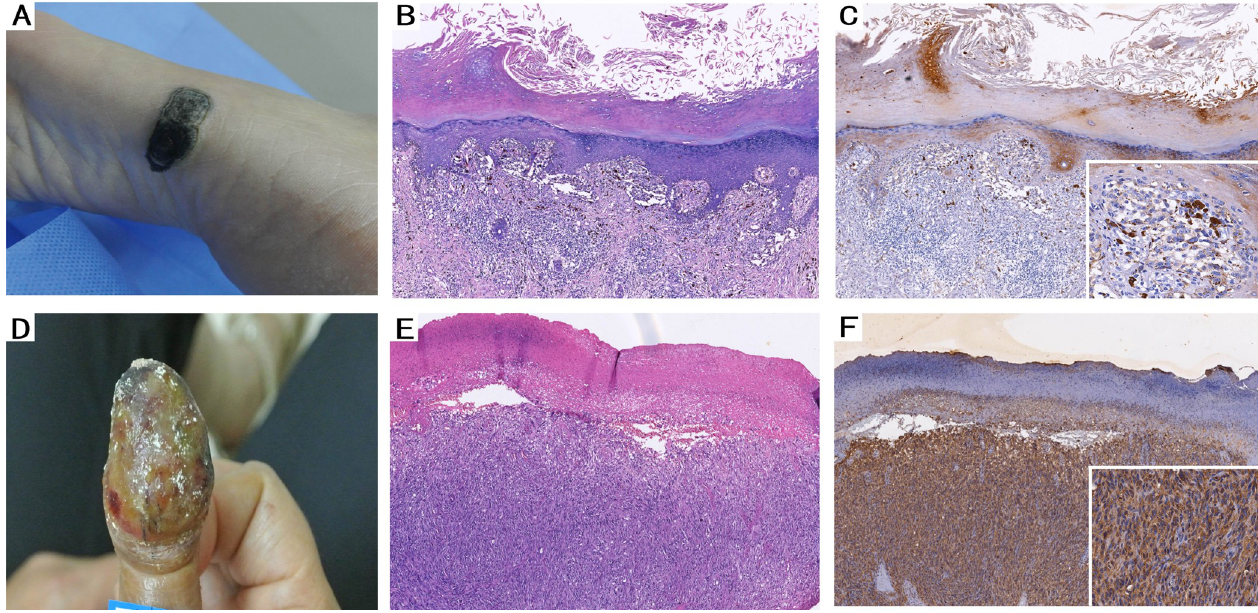
Fig 2. HSP105 expression in non-exposed site and exposed site. (A) Clinical picture of the LMM located in foot (non-exposed site). (B) Histological appearance (HE, × 100) in the LMM located in non-exposed site and (C) HSP 105 expression showed focal staining (IHC × 100). (D) Clinical picture of the LMM located in hand (exposed site). (E) Histological appearance (HE, × 100) in the LMM located in exposed site and (F) HSP 105 expression showed intense staining (IHC × 100).